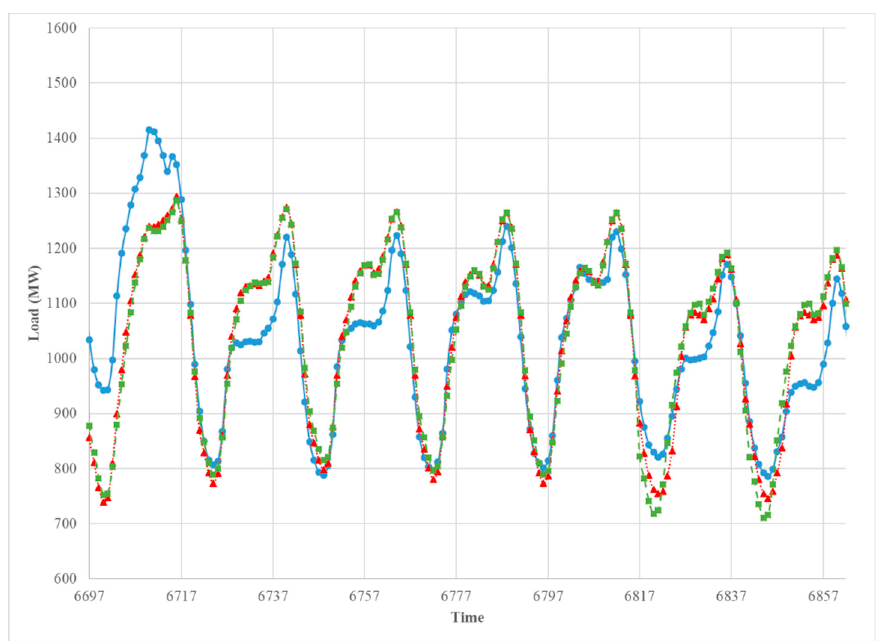
Figure 13. The comparison between the observed hourly load (blue solid), the predicted hourly load of Model 1 (red doted), and Model 2 (green dashed). 8 July 2013–14 July 2013. Energies 2019 , 12 , x FOR PEER REVIEW